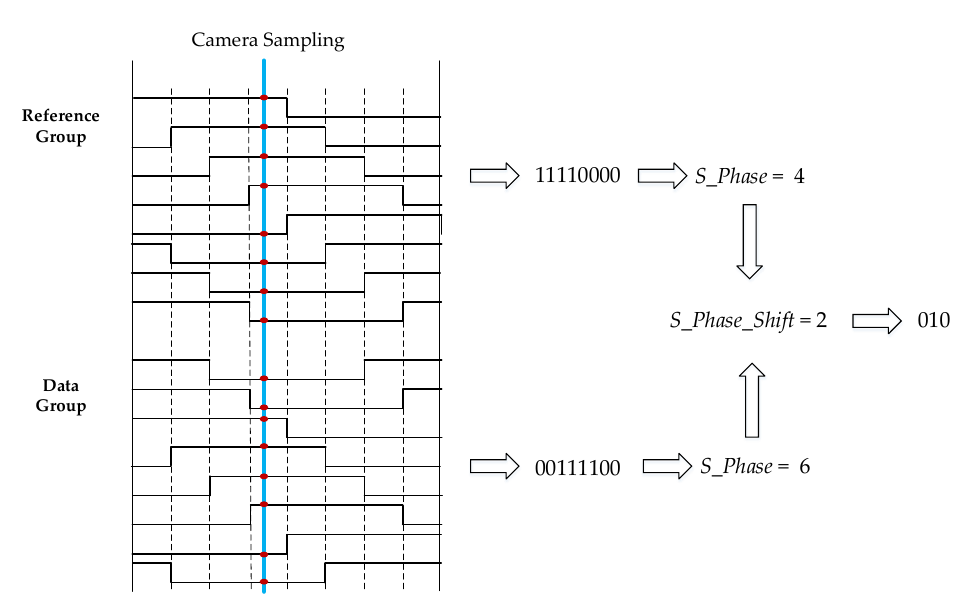
Figure 4. An illustration of sampling DS8-PSK waveform and calculate S_Phase_Shift with dimming level = 4 / 8 (50%). Table 2. S_Phase value definition for the captured set of binary LED group states under dimming condition (Adapted from [30]).